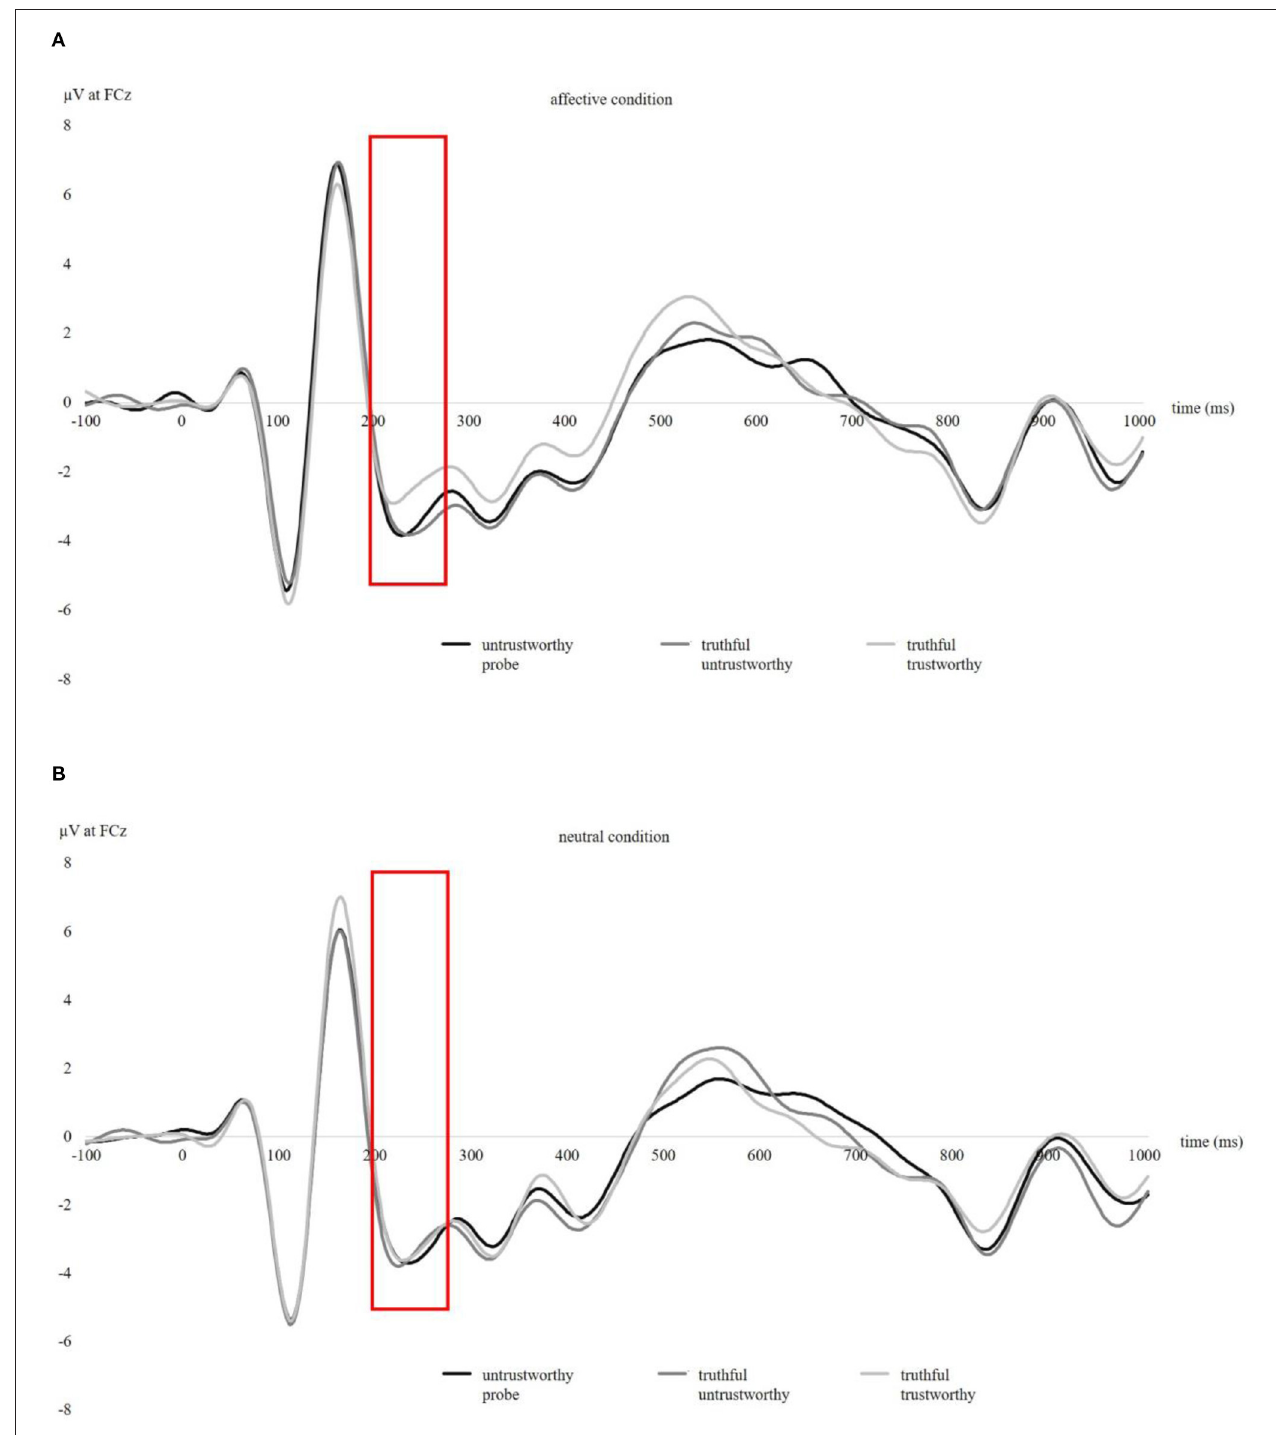
FIGURE 2 | Stimulus-locked grand averages at FCz from 0 to 1,000ms post-stimulus, with a 100ms pre-stimulus baseline for three picture types (untrustworthy-probe, truthful untrustworthy, truthful trustworthy) in the affective condition (A) and neutral condition (B) . Stimulus was presented from 0 to 700ms. N2 amplitudes were identified between 200 and 275ms